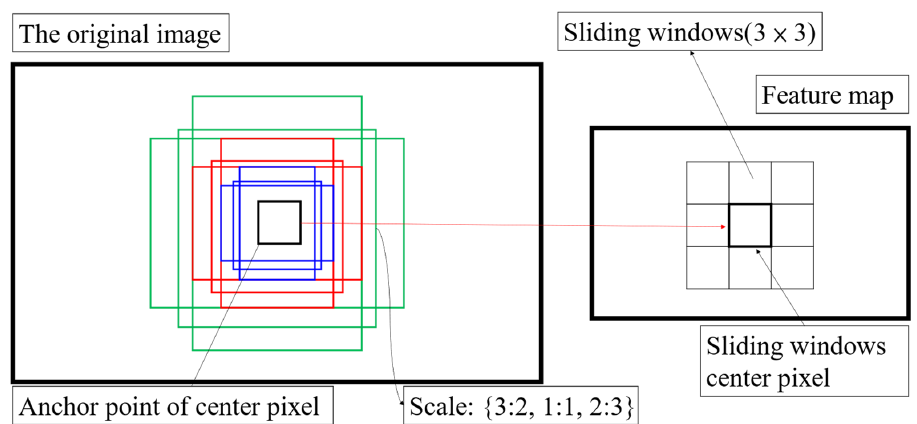
Figure 9. The anchor method architecture used in this SiamRPN.